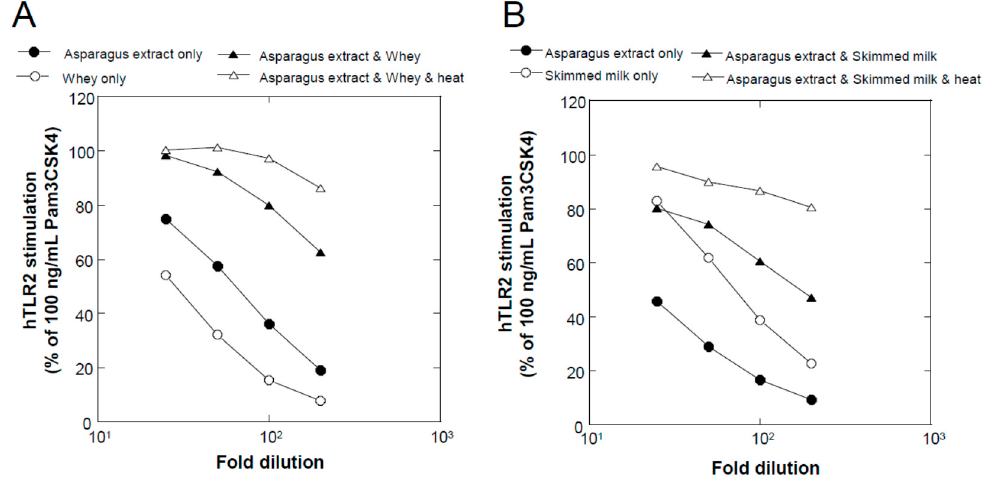
Figure 3. Contribution of asparagus extract and milk components to the TLR2-stimulating activity of TL24 ferments. ( A ) Hot water extract of asparagus (closed circle), 8.3% cheese whey (open circle), or their mixture (closed triangle) was used as the medium for TL24 fermentation. After 24 h of static culture, the supernatants were sampled, and their TLR2-stimulating activity was examined. Before sampling, the ferments in the mixture medium were heat-treated (at 110 ° C for 20 min), and the activity of the supernatant was examined (open triangle). In this experiment, the media were sterilized at 75 ° C for 30 min before fermentation. ( B ) We used 3% cow skimmed milk instead of cheese whey in Figure 3A, with sterilization at 110 ° C for 20 min before fermentation.